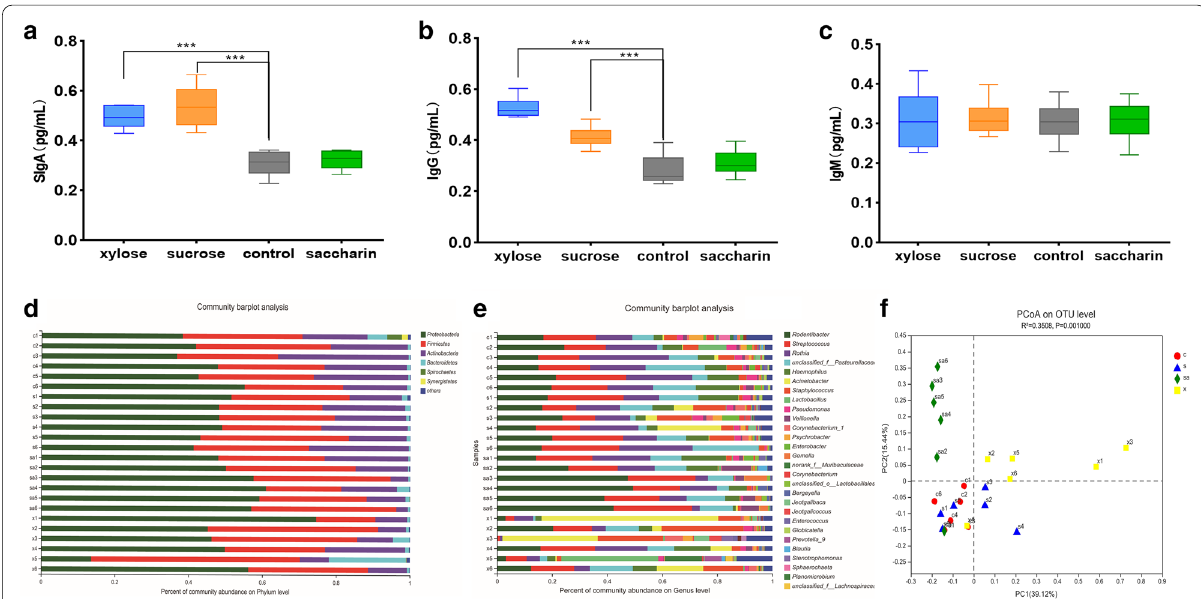
Fig. 1 This image consists of six parts, a , b , and c representing the results of each of the individual rat saliva immunoglobulin ELISAs. Oral bacterial community at the phylum ( d ) and genus ( e ) levels. Relative abundance of bacterial groups in each of the 24 oral cavity samples (black). Any phylum or genus with an abundance of less than 1% was merged into other groups. f Principal coordinate analysis (PCoA) of the microbial communities. Red circles, Blue triangles, Green diamonds, and Yellow squares represent the gut microbiotas of samples from the control (c group), sucrose (s group), saccharin (sa group), and xylose (x group) groups, respectively. * 0.01 < p